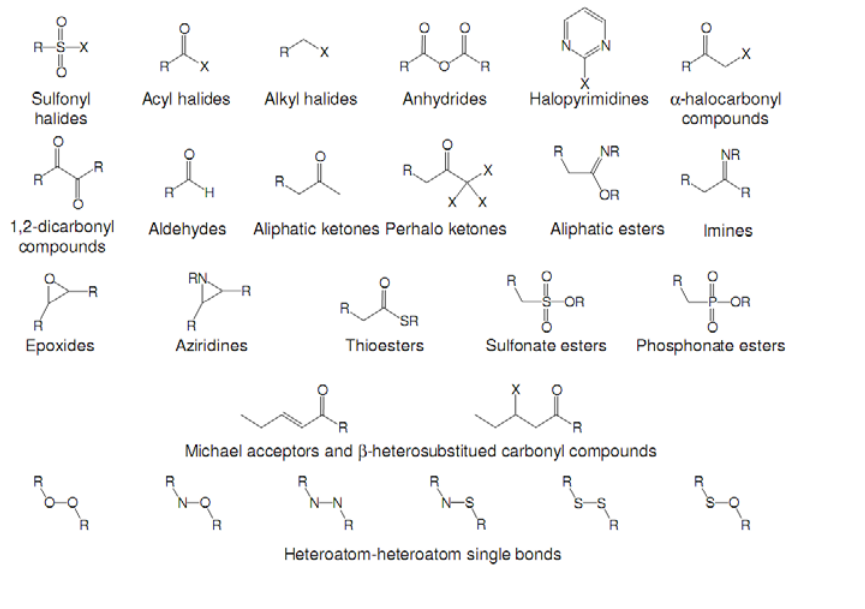
Figure 6. Nonleadlikness filter. The substituent ty pes were extracted fro m Rishton work [34]. The electrophilic functional groups shown here are the most common protein-reactive covalent-acting false positives in biochemical assays. Compounds with substituents shown in this figure were removed from our